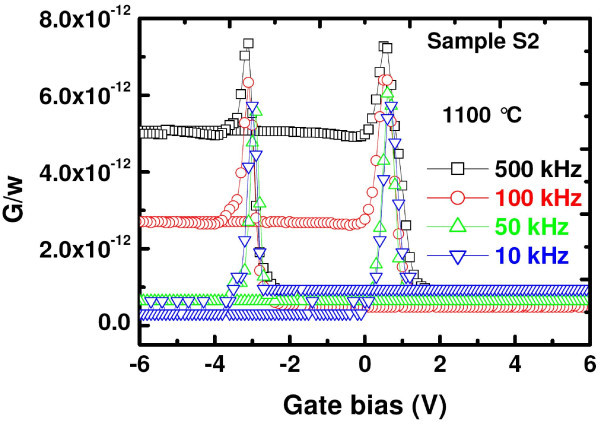
(Color online) Frequency-dependent G-V characteristics of Al/Si3N4/SRSN/SiO2/Si (MNNOS) structure containing 25 at.% of Si excess in the range 10-500 kHz.